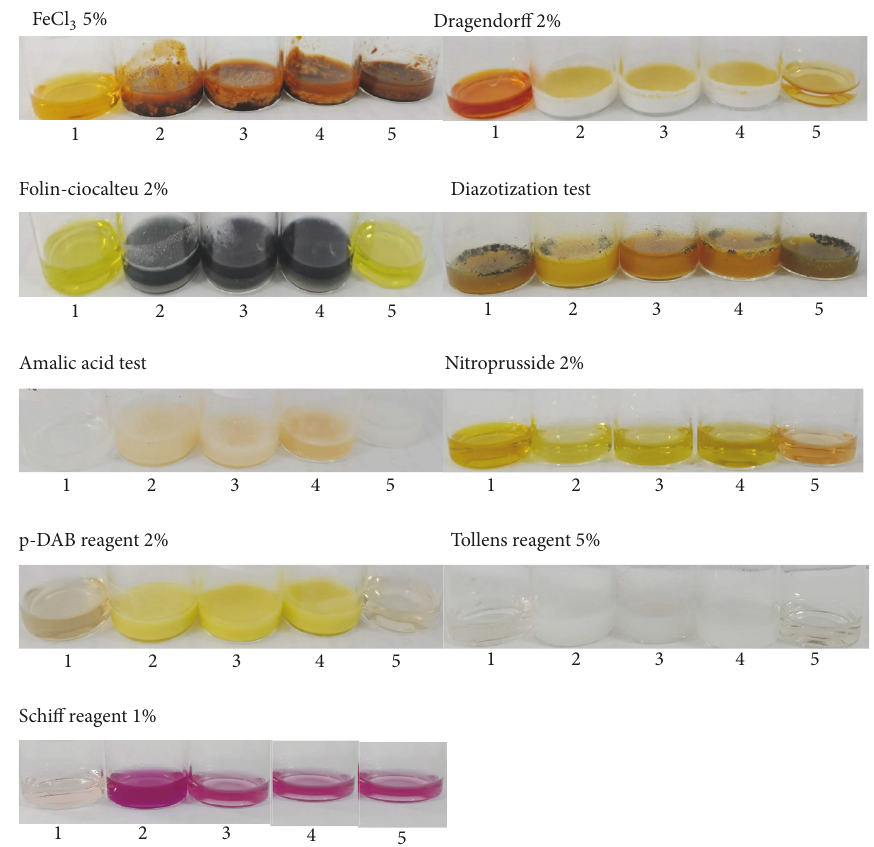
Figure 2: Color change of colorimetric reagent in the presence of (1) reagent, (2-4) allopurinol solution (100 mg/ml), and (5) NaOH 2 N as a blank